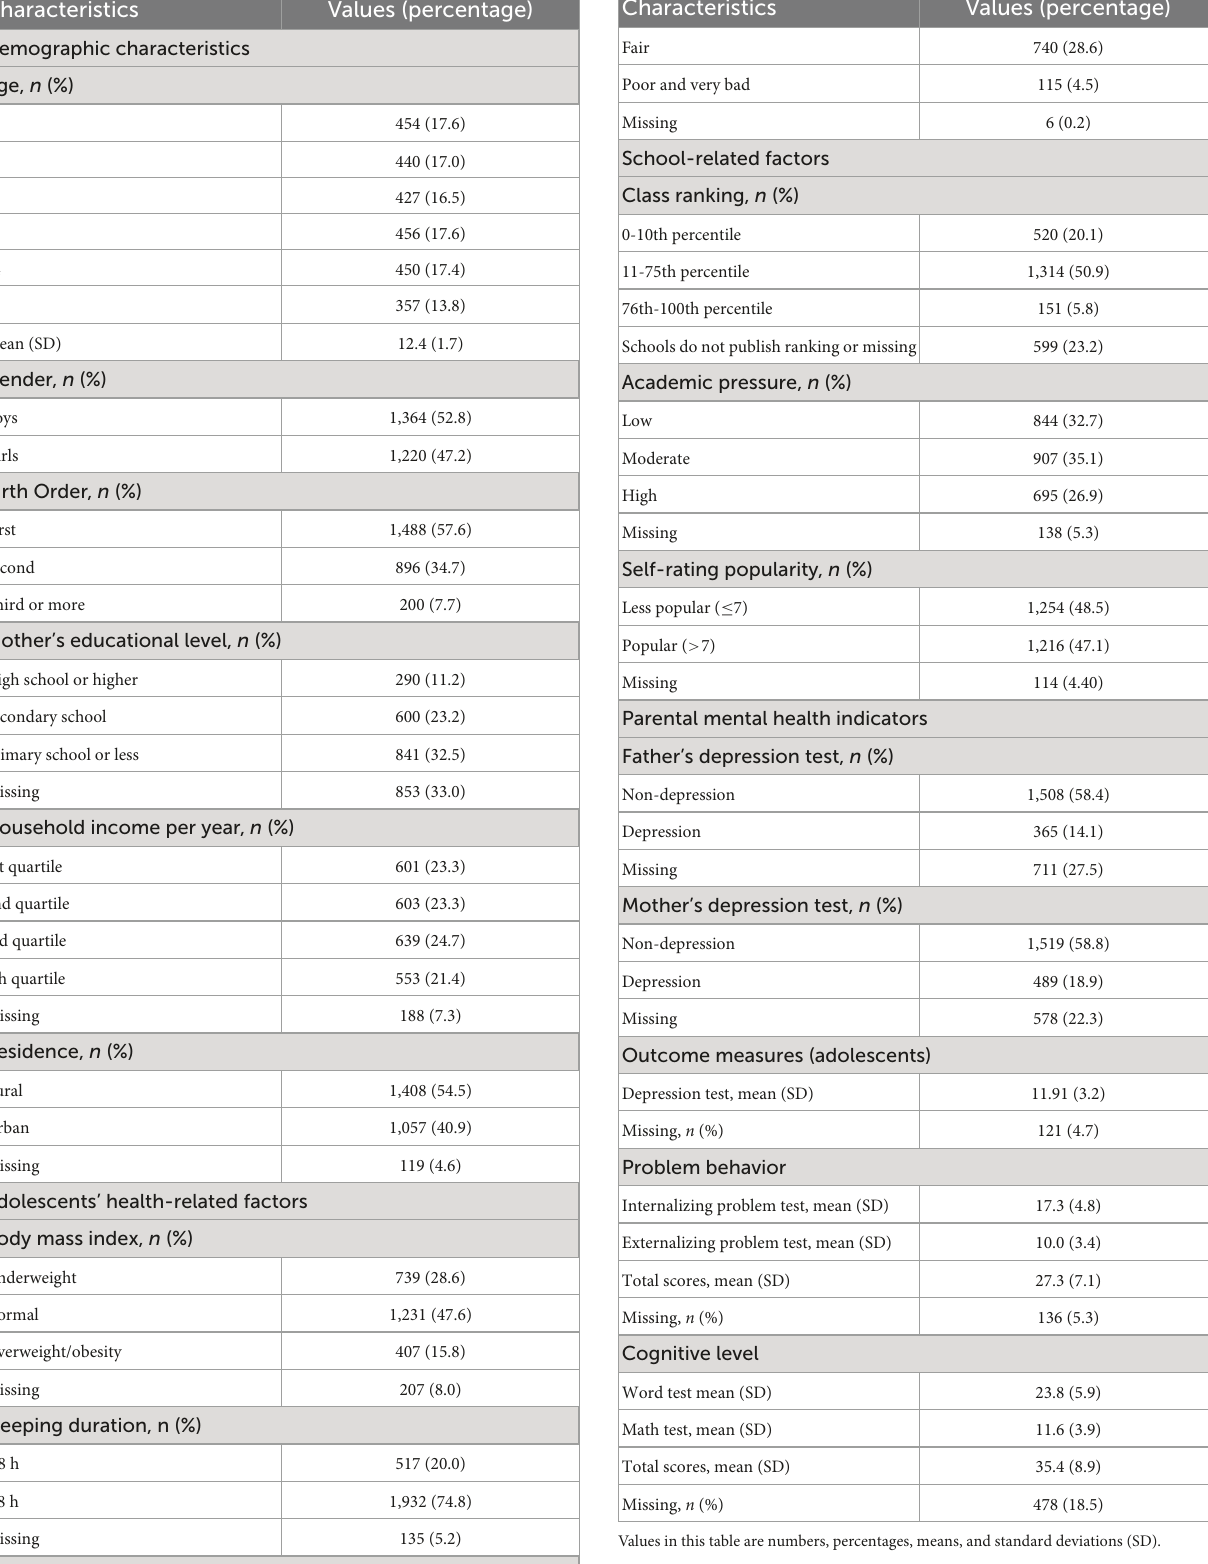
TABLE 1 General characteristics of the study population ( n =